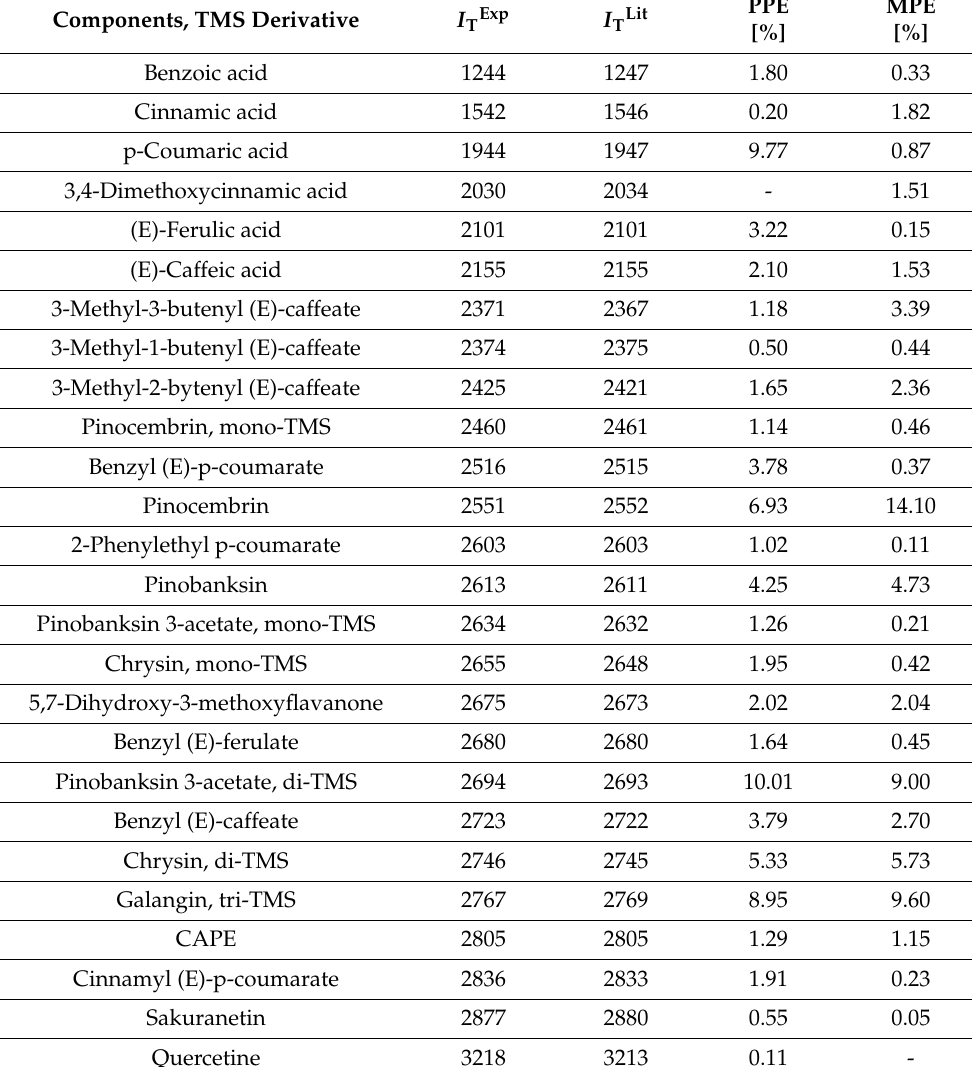
Table 2. The main chemical compounds of the ethanolic extracts of propolis from Poland (PPE) and propolis from New Zealand (MPE), determined by GC-MS.